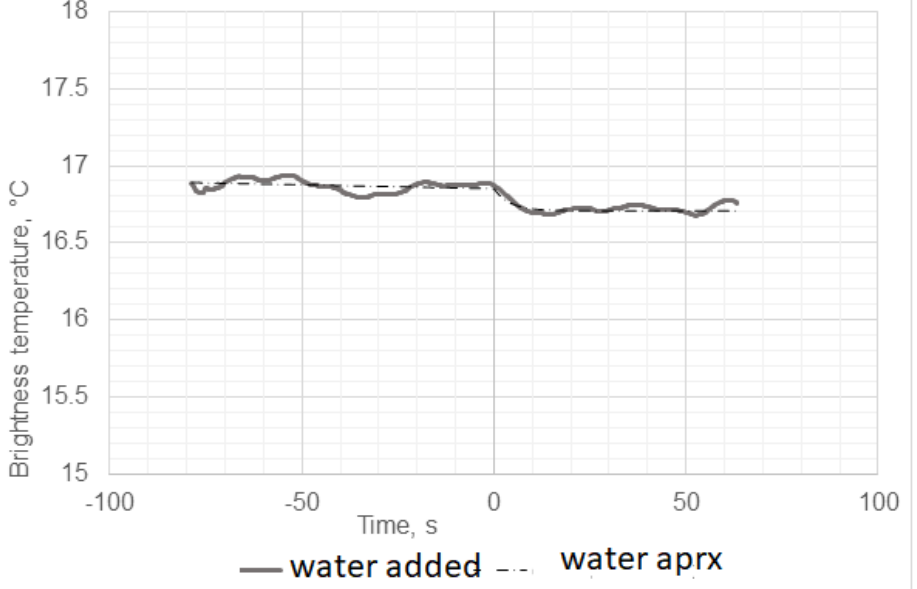
Figure 6. Microwave emissions (brightness temperature) when adding tap water (30 mL) to egg white at Time 0.